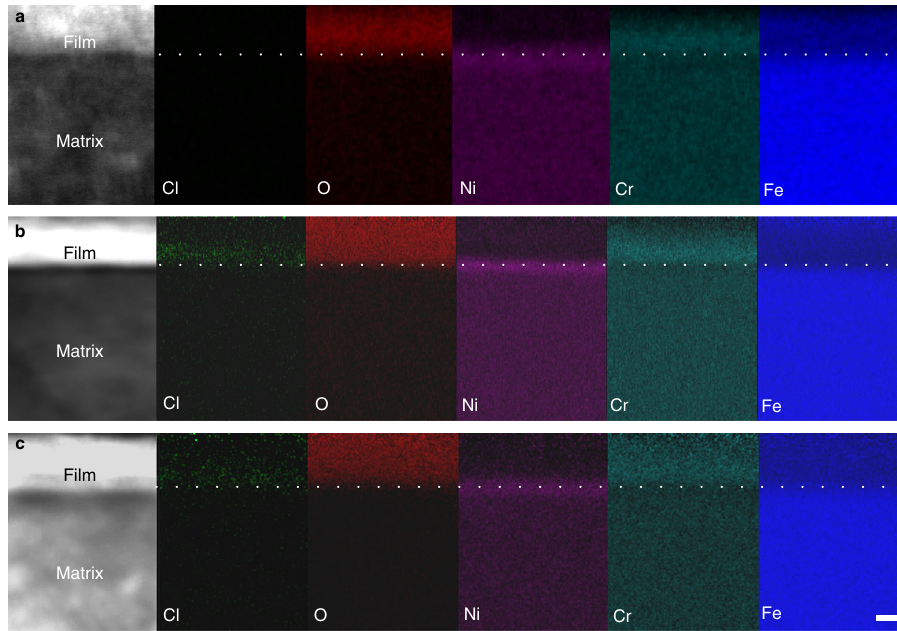
Fig. 2 Super-X EDS mapping showing chloride ion incorporated in and penetrating the passive fi lm and accumulating at the matrix/passive fi lm interface. Element maps of the fi lm formed in a 0.5 mol L − 1 H 2 SO 4 electrolyte at 640 mV/SHE for 30 min; b 0.5 mol L − 1 H 2 SO 4 + 0.3 mol L − 1 NaCl electrolyte at 640 mV/SHE for 30 min, and c passivated in 0.5 mol L − 1 H 2 SO 4 electrolyte at 640 mV/SHE for 30 min with subsequent addition of NaCl. All scale bars in